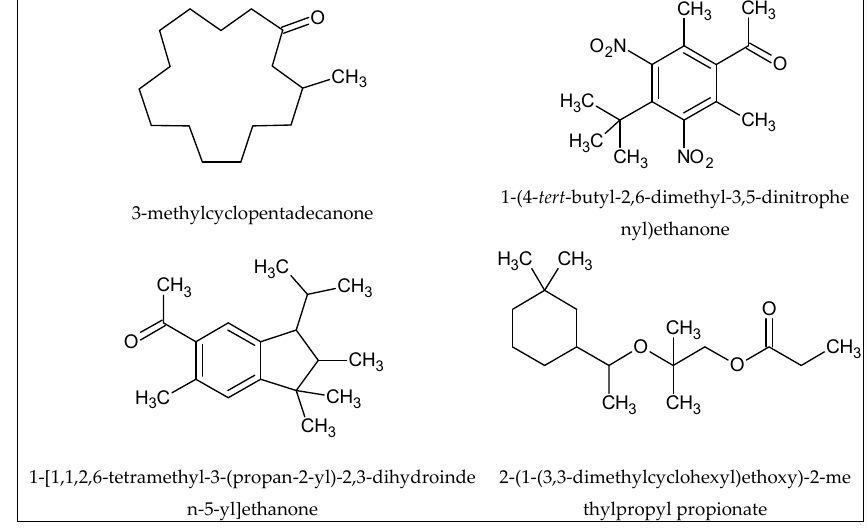
Figure 4. Examples of odorants with different structures and similar odors (musk) [32,37].